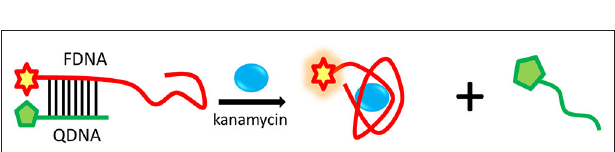
FIGURE 3 | Schematic illustration of the structure-switching aptamers assay for kanamycin detection based on the FRET. powder LC-MS/MS method). Eight grams of milk and 30 mL 5% phosphoric acid solution were mixed for 10 min, then added 3 mL trichloroacetic acid. The mixture was thoroughly vortex- mixed and centrifuged at 4,000 r/min for 4 min. The supernatant was successively purified with the solid phase extraction columns of benzenesulfonate and carboxylic acid. The purified sample solution was filtered through the filter membrane (0.2 µ m) and then the LC-MS/MS was tested. Liquid chromatography used